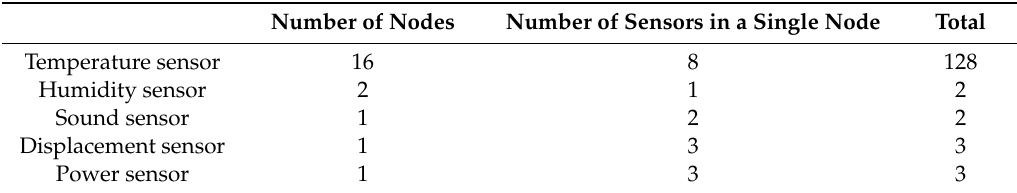
Table 2. Types and number of sensors.